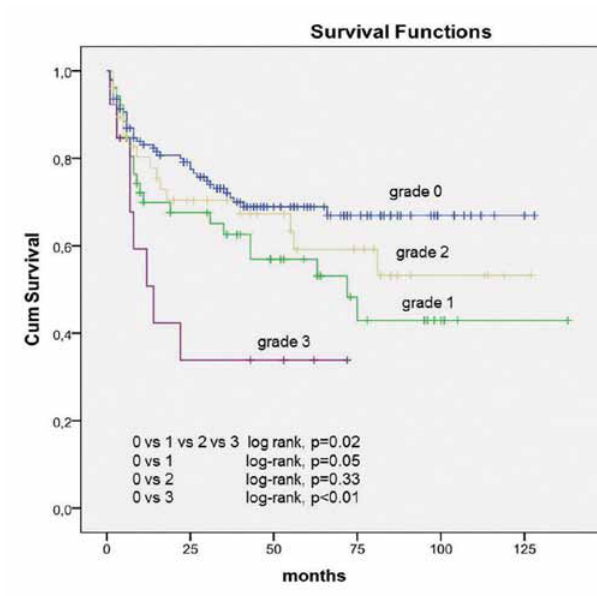
Figure 2 - Kaplan-Meyer product-limit analysis comparing grades 0, 1, 2, and 3 reactive stroma on needle biopsy from 254 patients for time to biochemical recurrence following radical